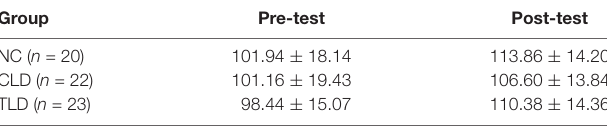
TABLE 2 | Scores of Raven’s advanced progressive matrices (APM) test of each group in pre- and post-test training.